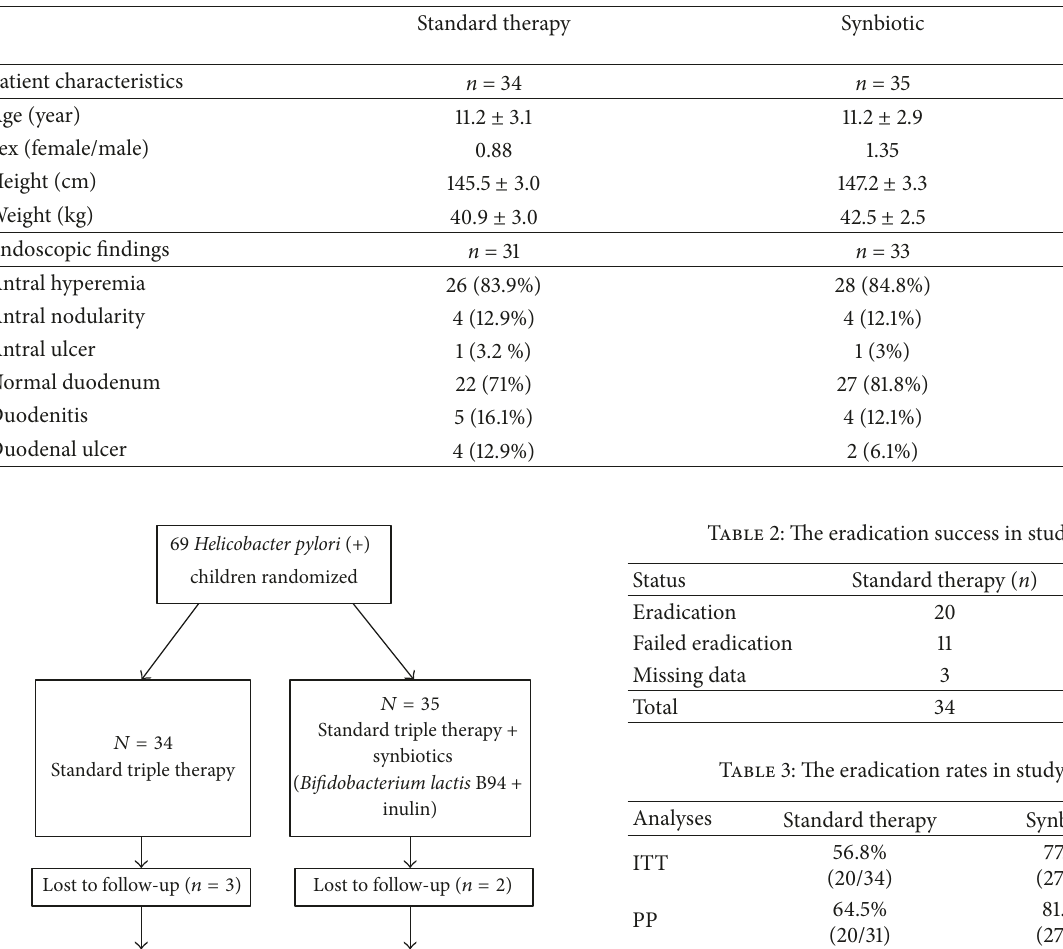
Table 1: Demographic characteristics and endoscopic findings of study groups.